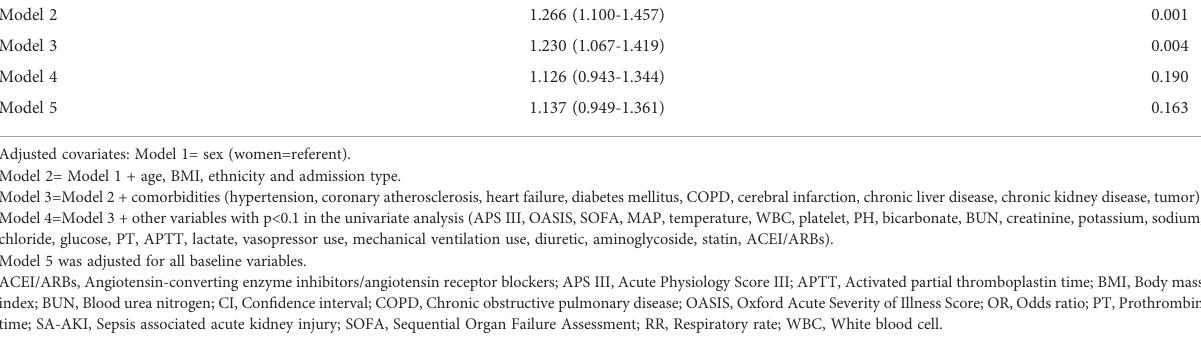
standardized mean difference being<0.1 for all variables ( Figure S1 ; Table 4 ). No differences in ICU and hospital mortality between men and women were found (ICU mortality, men vs. women, 19.72% vs. 20.42%, p = 0.595, Figure 7B ; hospital mortality, men vs. women, 25.62% vs. 25.77%, p = 0.991, Figure 7D ).